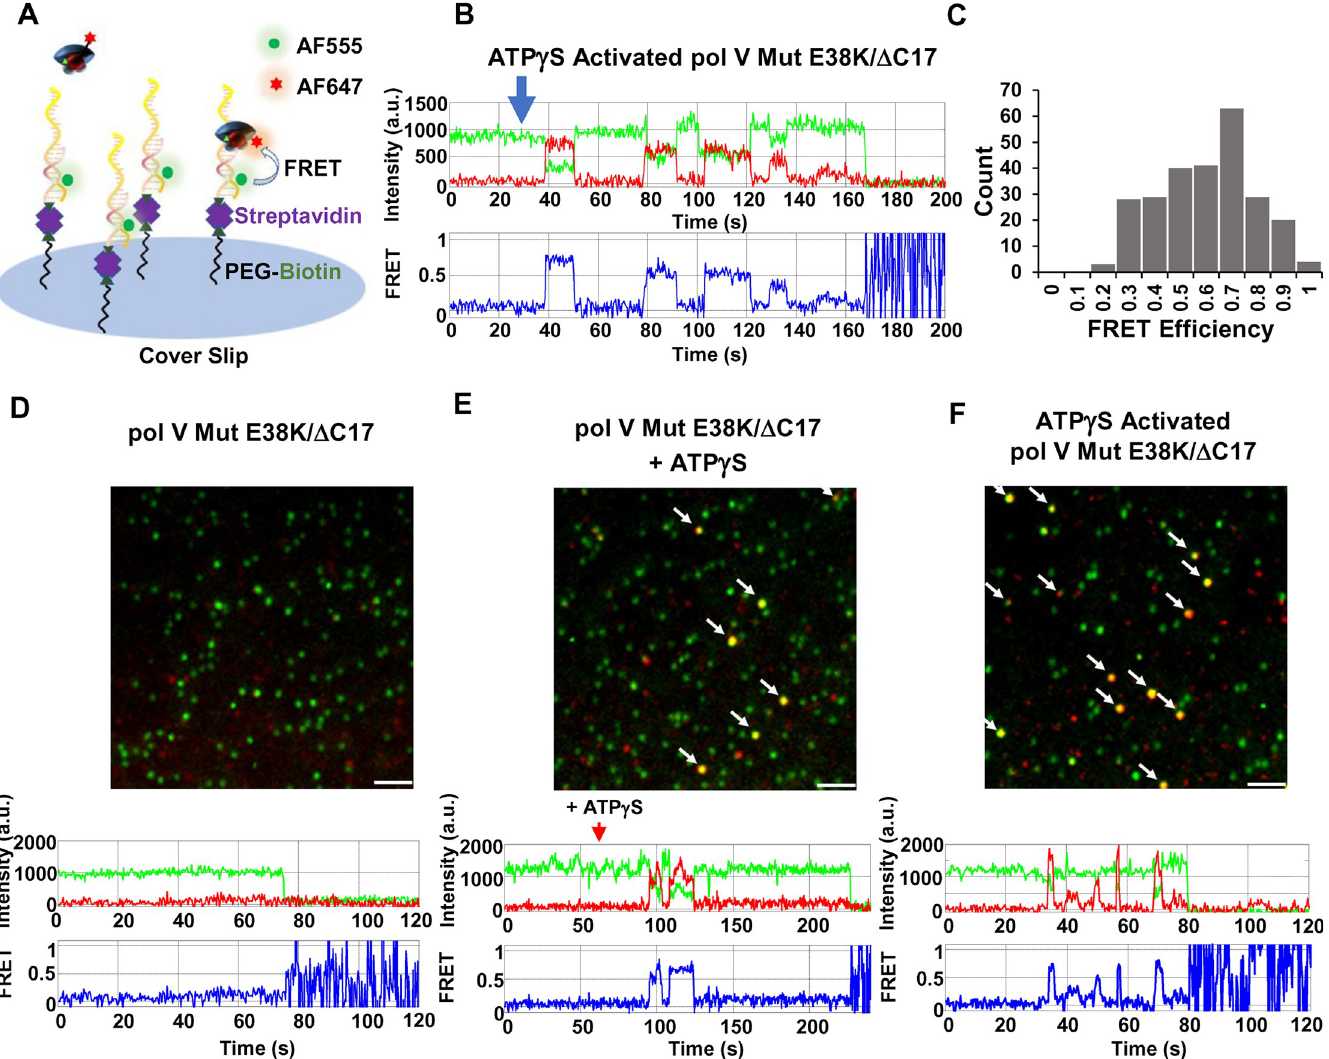
Fig 7. Pol V Mut binding to p/t DNA visualized at single-molecule resolution in real-time. (A) Sketch of smFRET experimental setup. An AF555 donor-labeled p/t DNA linked to streptavidin-biotin is attached to a glass slide surface. AF647 acceptor-labeled pol V Mut is then added, and DNA binding is observed as an increase in acceptor fluorophore emission that counter-correlates with a drop of a donor emission. (B) A representative smFRET trajectory showing multiple binding and unbinding events of ATP γ S-activated pol V Mut E38K/ Δ C17 (green = donor, red = acceptor, blue = FRET efficiency). ATP γ S-activated pol V Mut was added at t = 30 s after the start of image acquisition. Data were collected for up to 3 min, prior to the onset of photobleaching. (C) Histogram representing smFRET efficiencies corresponding to the binding of ATP γ S-activated pol V Mut E38K/ Δ C17 to AF555-labeled p/t DNA. FRET efficiency is calculated as E = I A / (I D +I A ), where I A and I D represent acceptor and donor emission respectively. (D-F) Representative smFRET images are shown along with representative individual FRET trajectories of ATP γ S- dependent binding of pol V Mut E38K/ Δ C17 to p/t DNA. AF555-labeled p/t DNA is shown as green spots, and unbound AF647-labeled pol V Mut E38K/ Δ C17 is shown as red spots. The pol V Mut E38K/ Δ C17-p/t DNA binding events are shown as colocalized pol V Mut E38K/ Δ C17 and p/t DNA signals (yellow/orange spots). Pol V Mut E38K/ Δ C17 (D-E) or ATP γ S activated pol V Mut E38K/ Δ C17 (F) is added at t = 30 s after the start of image acquisition, followed by addition of ATP γ S (t = 60 s, middle panel). Pol V Mut does not bind p/t DNA in the absence of ATP γ S (D and S1 Movie). The addition of ATP γ S activates pol V Mut E38K/ Δ C17, resulting in binding to p/ t DNA (E and S2 Movie) and pol V Mut E38K/ Δ C17-p/t DNA binding events are indicated by the arrows. If pol V Mut is activated by ATP γ S prior to addition to p/t DNA (F and S3 Movie), multiple and rapid p/t DNA binding events occur, indicated by arrows. The images shown in (D-F) are smFRET data integrated over 1 min following pol V Mut addition (left panel) or first binding events (middle and right panels). Scale bar is 150